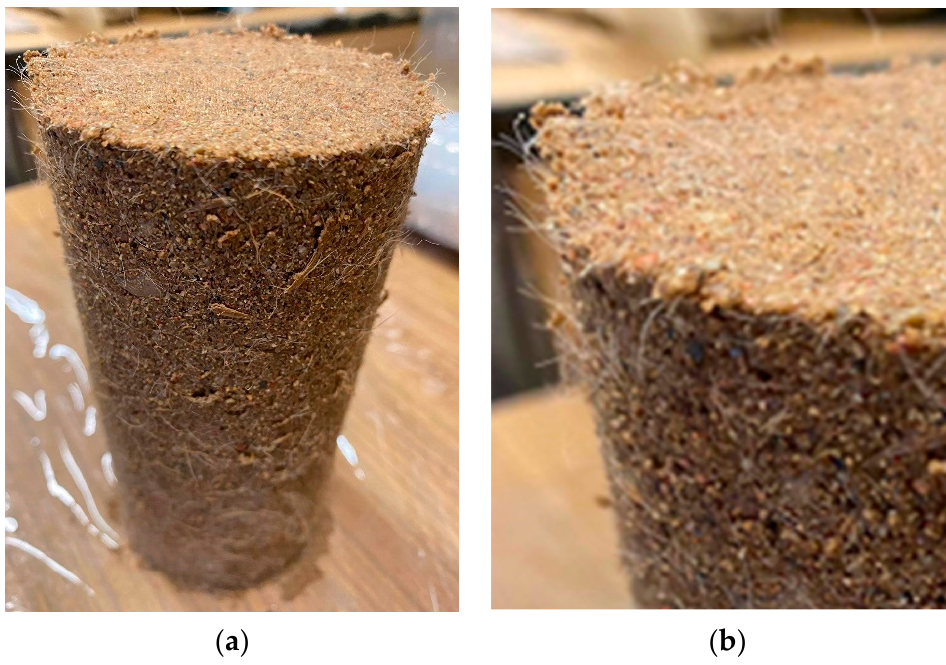
Figure 5. Image of a sample (grSa + 1.5C + 0.3%F 18 mm) compacted via SP method: ( a ) sample directly after compaction, ( b ) magnification of the sample with a visible homogeneous distribution of reinforcement.